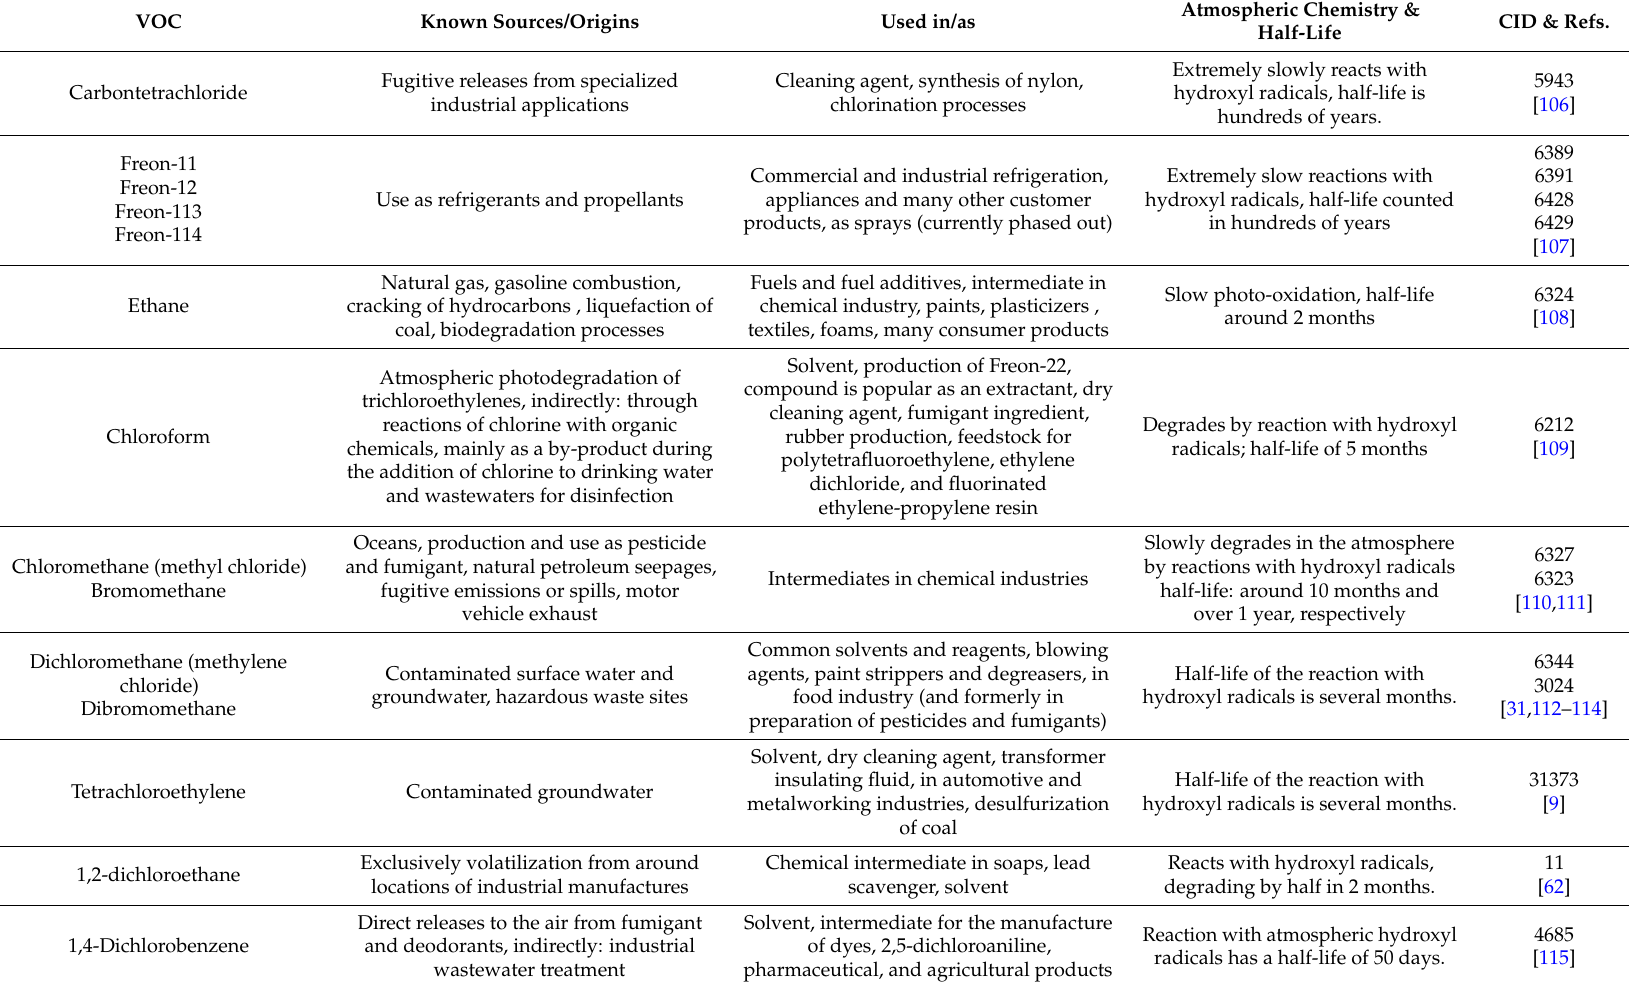
Table 4. Inert gases characterizing the inert/stable background of urban air